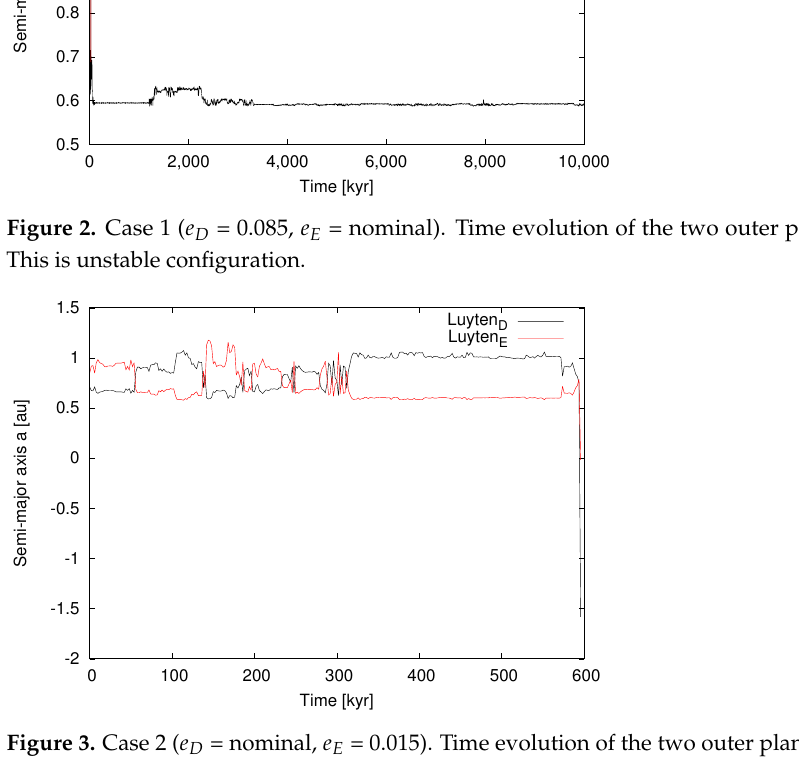
Figure 3. Case 2 ( e D = nominal, e E = 0.015). Time evolution of the two outer planets over 10 Myr. In this unstable configuration, the planets end up